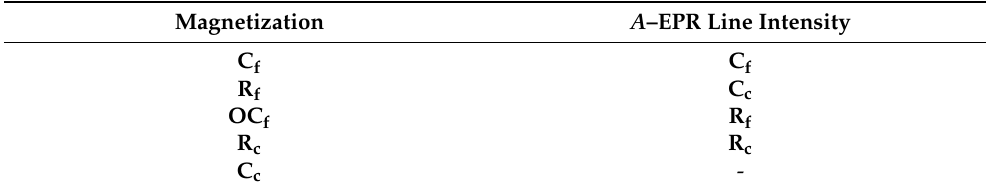
Table 3. Ranking from larger to lower magnitudes of room temperature magnetization (Figure 4a,b) and EPR A -line intensity (Figure 5b) in the powders under